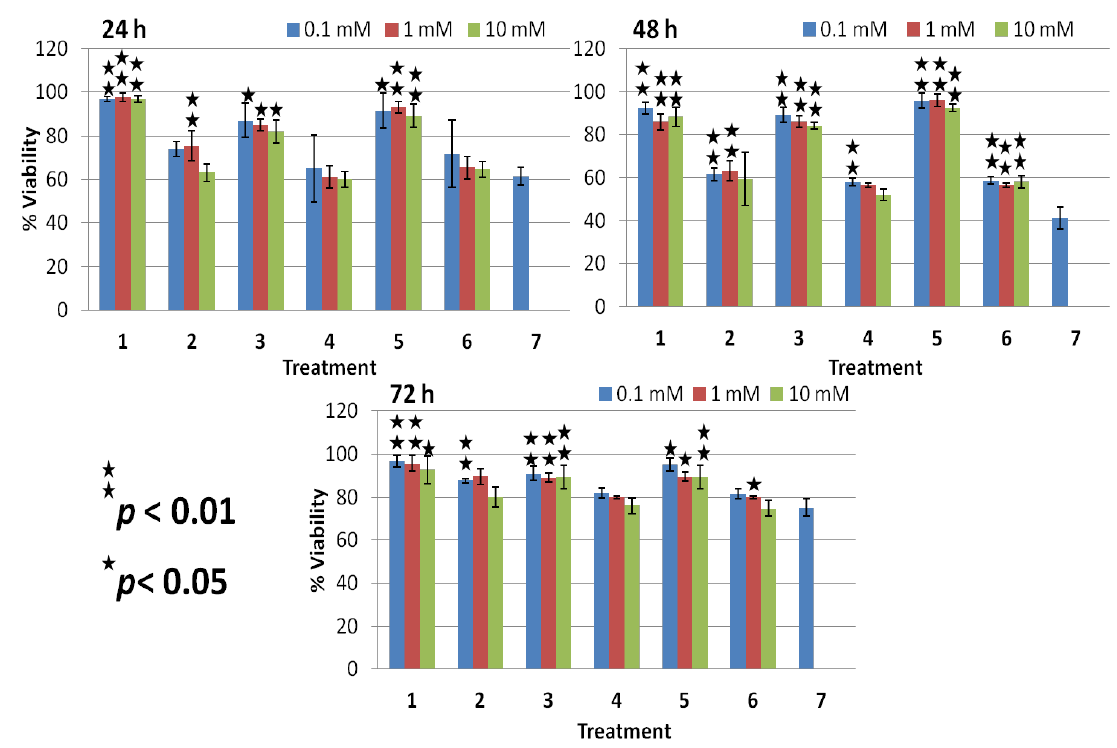
Figure 6. % Viability evaluated from MTT assay on treated HEK normal cells at lower concentrations of osmolytes (0.1 mM, 1 mM and 10 mM) with or without plasma. Data presented are mean ± SD of at least three independent experiments (n = 3) and statistically